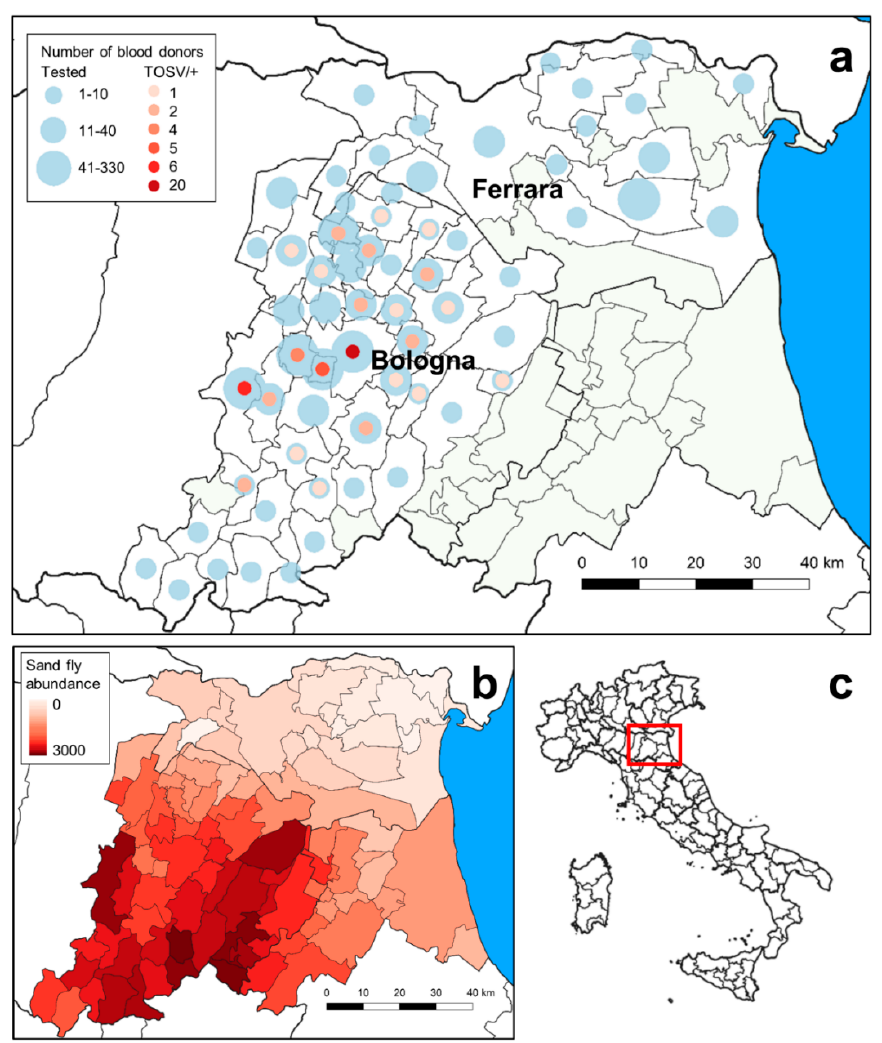
Figure 2. ( a ) Distribution of blood donors included in the study (light blue circles) and anti-TOSV IgG-positive individuals (red-colored circles) for each municipality in the surveyed area (circle areas are proportional to the effective number of individuals, reference number in the legend). ( b ) Choropleth map of the estimation of sand fly abundance obtained by the model for each municipality (from 0 to 3000 sand flies sampled). ( c ) Location of the surveyed area in Northeastern Italy.